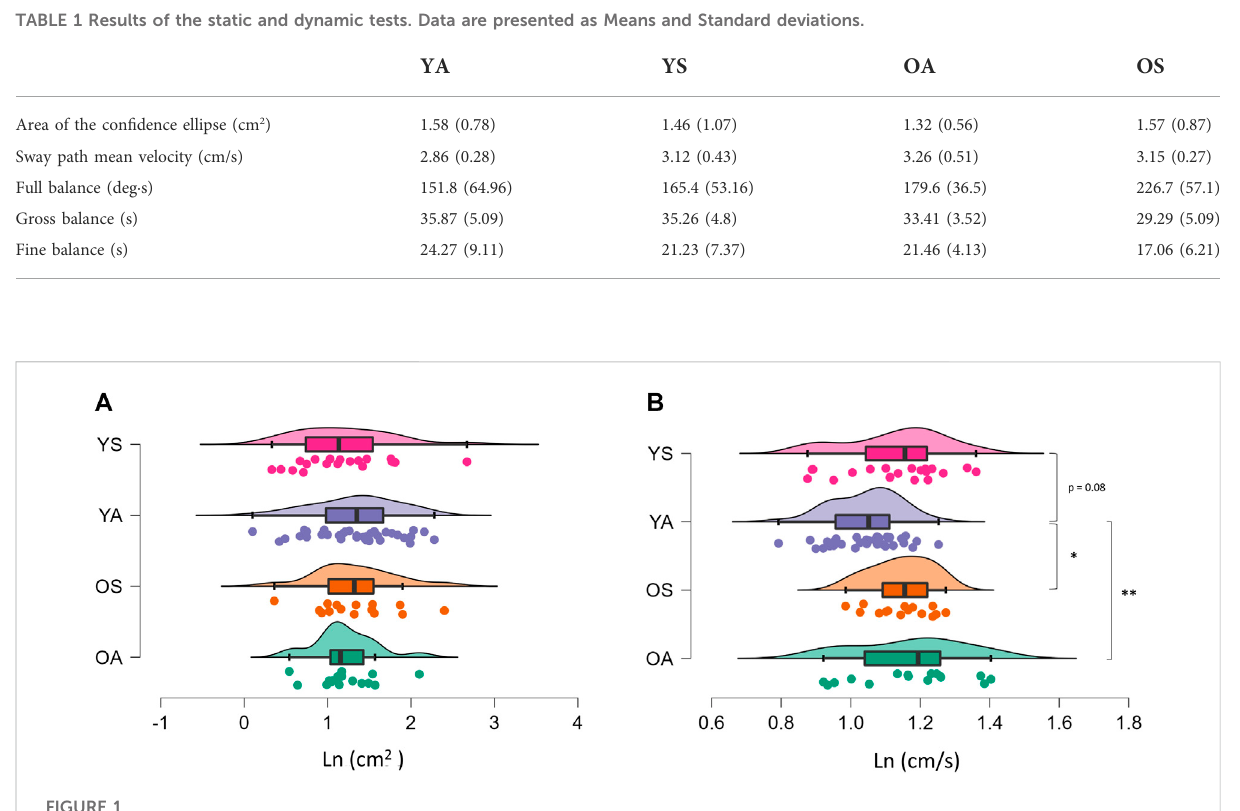
FIGURE 1 Raincloud plot of the differences among groups concerning the static postural balance control. The ‘ cloud ’ illustrates data distribution, while the ‘ rain ’ thejitteredrawdata. (A) areaofthecon fi denceellipse; (B) swaypathmeanvelocity.* p < 0.05;** p < 0.01.YA:physicallyactiveyoungadults; YS: sedentary young adults; OA: older active adults; OS: older sedentary